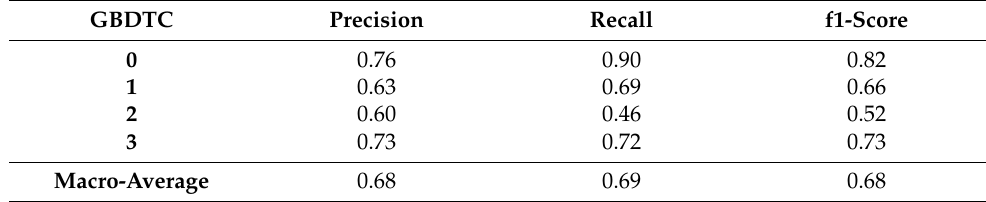
Table 10. Performance of